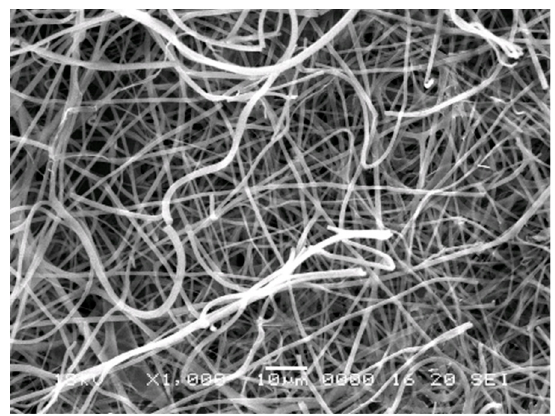
Figure 1. Scanning electron micrograph of electrospun polycaprolactone (PCL) membrane showing its porous and fibrous structure. The average fiber diameter is 0.82 microns.